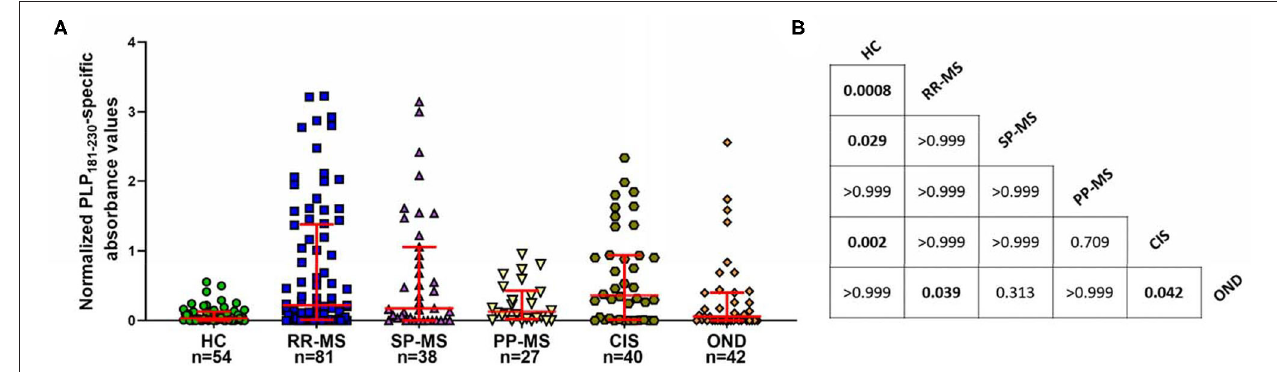
FIGURE 3 | (A) Comparison of anti-PLP 181 − 230 antibody levels in the different MS subgroups and in patients with CIS. PP-MS patients have lower levels of anti-PLP 181 − 230 antibodies than do other groups of MS patients or individuals with CIS. (B) Chart showing the P -values for comparison of all groups shown in (A) Significant differences are highlighted in bold. Analyzed using Kruskal-Wallis test with Dunn’s multiple comparison test.